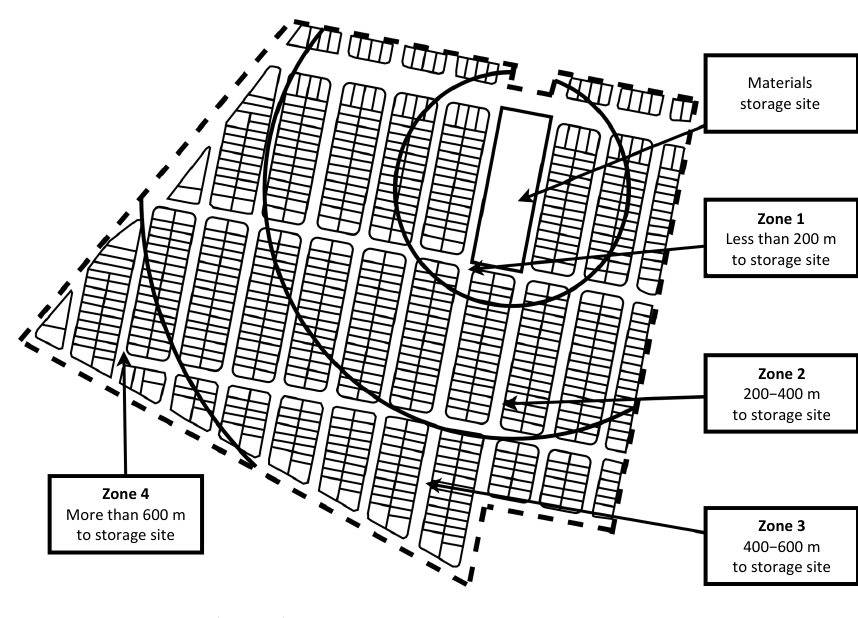
Figure 10. Case study site layout.